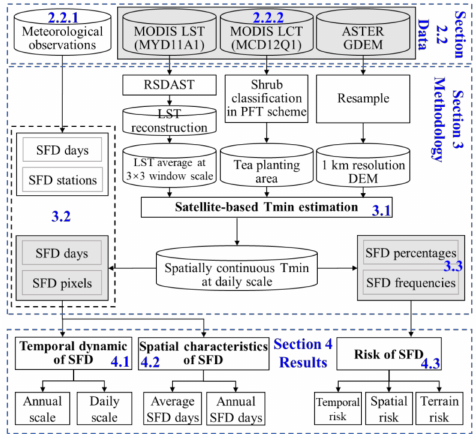
Figure 2. The pipeline of spring frost damage (SFD) to tea plants using satellite-based Tmin estimation. The data used in this study includes ground-based meteorological observations (describes in Section 2.2.1) and remotely sensed products (in Section 2.2.2). The methodology mainly concerns three parts in this pipeline: (i) satellite-based Tmin estimation (in Section 3.1); (ii) spatiotemporal characteristics of SFD expressed as SFD days and SFD stations with ground-based Tmin observations, and SFD days and SFD pixels with satellite-based Tmin estimations (in Section 3.2); and (iii) three-dimensional risks of SFD with pixel-based SFD percentages and SFD frequencies (in Section 3.3). The spatiotemporal characteristics of SFD (in Sections 4.1 and 4.2) and its risk (in Section 4.3) to tea plants were exhibited in the bottom of the pipeline. Here, three gray boxes represent satellite-based data or method to distinguish them from the ground, and the blue number signs (such as Sections 2.2.1, 3.2 and 4.1, etc.) were the section labels in the